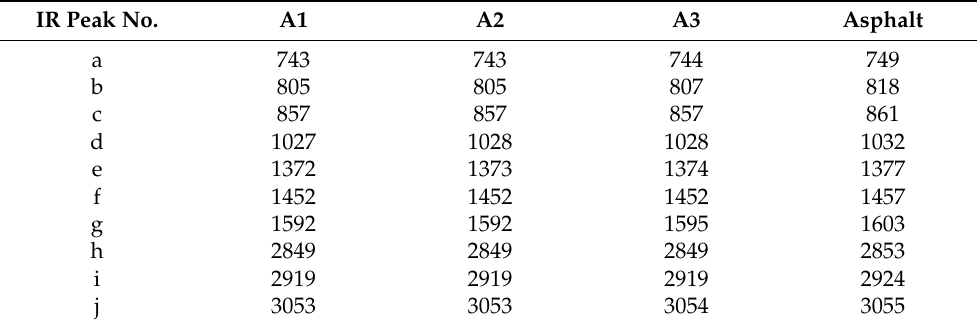
Table 6. The wave number (in unit of cm − 1 ) for main peaks on IR spectra for the extracted asphaltenes (A1, A2 and A3) and the base asphalt 1 . IR Peak No.